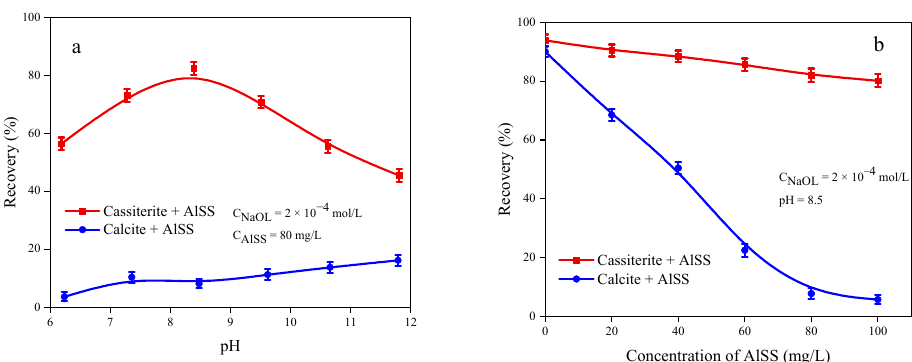
Figure 5. Effect of pH ( a ) and concentration ( b ) of SS on the flotation recovery of cassiterite and calcite.